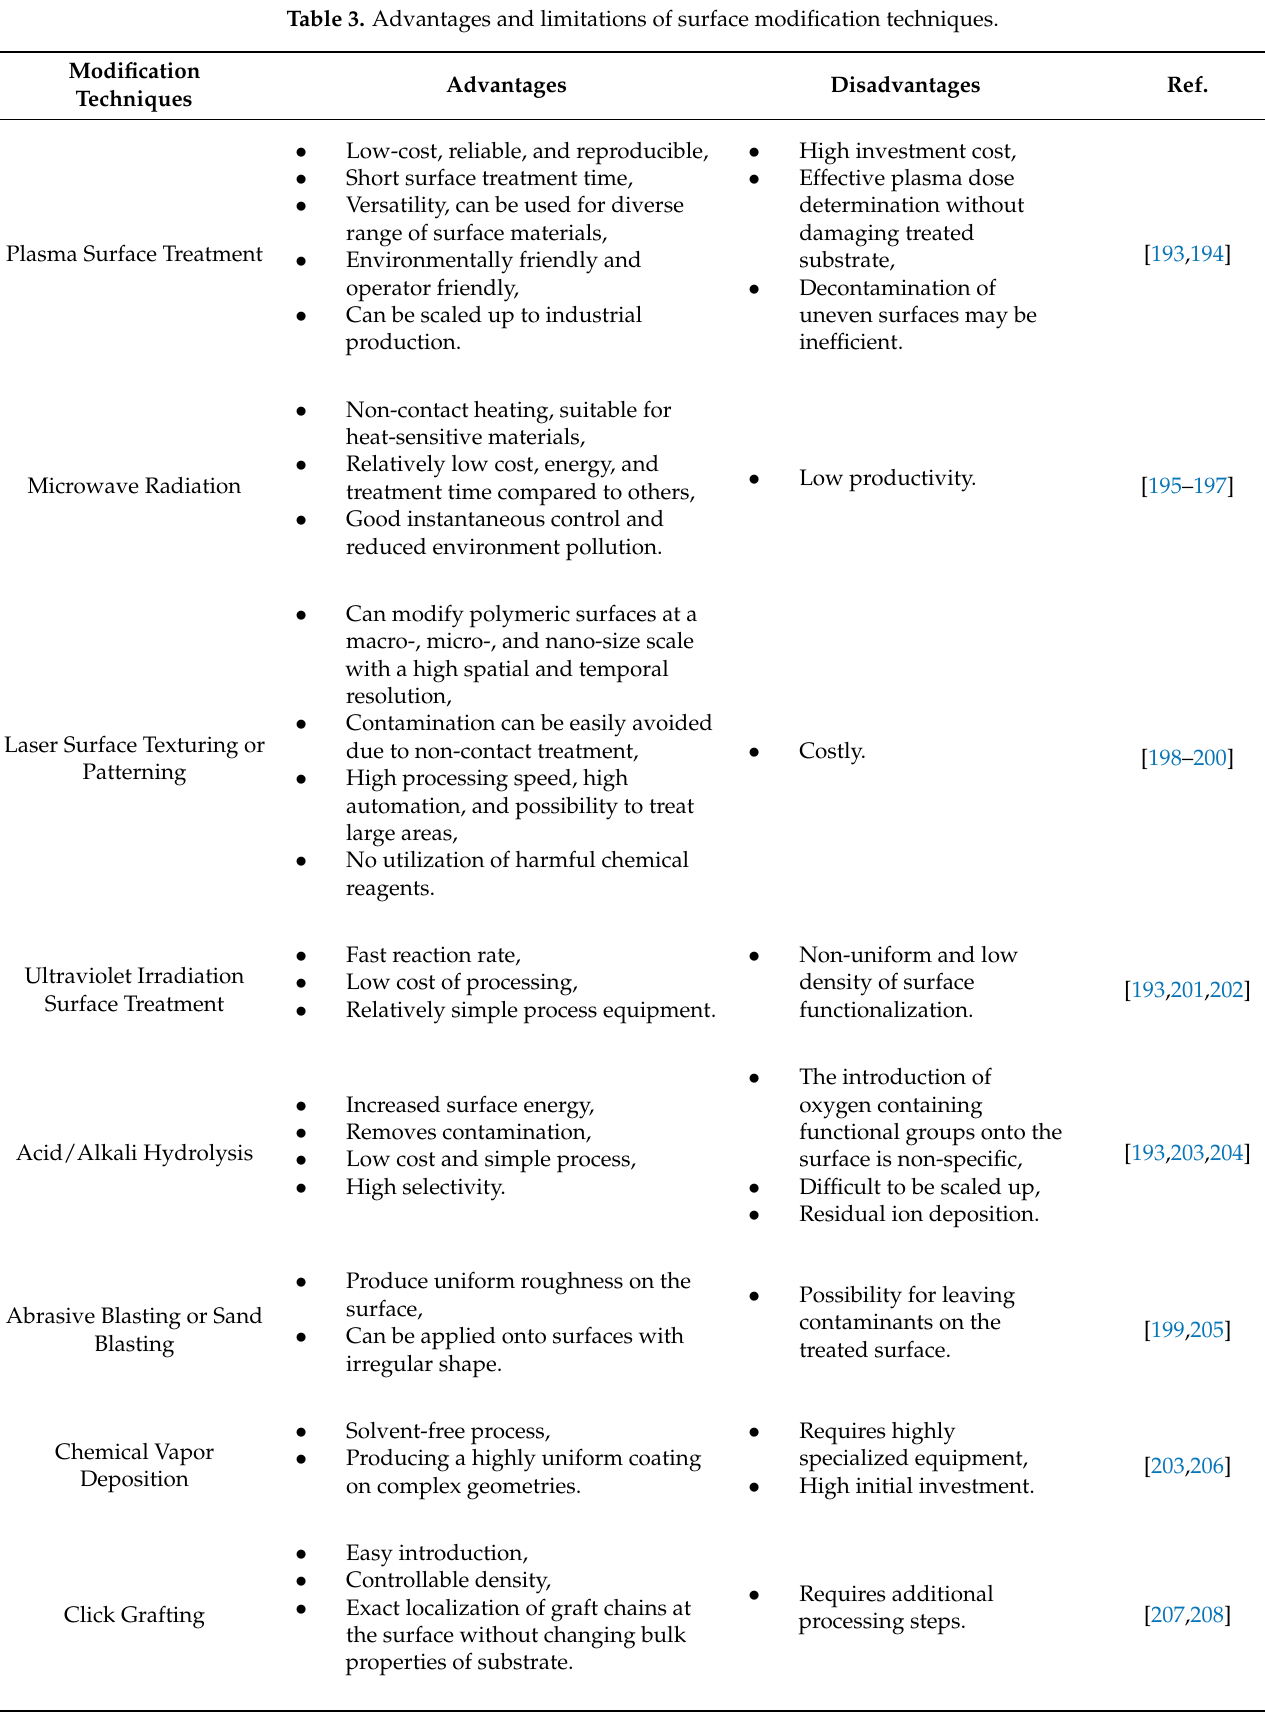
Table 3. Advantages and limitations of surface modification